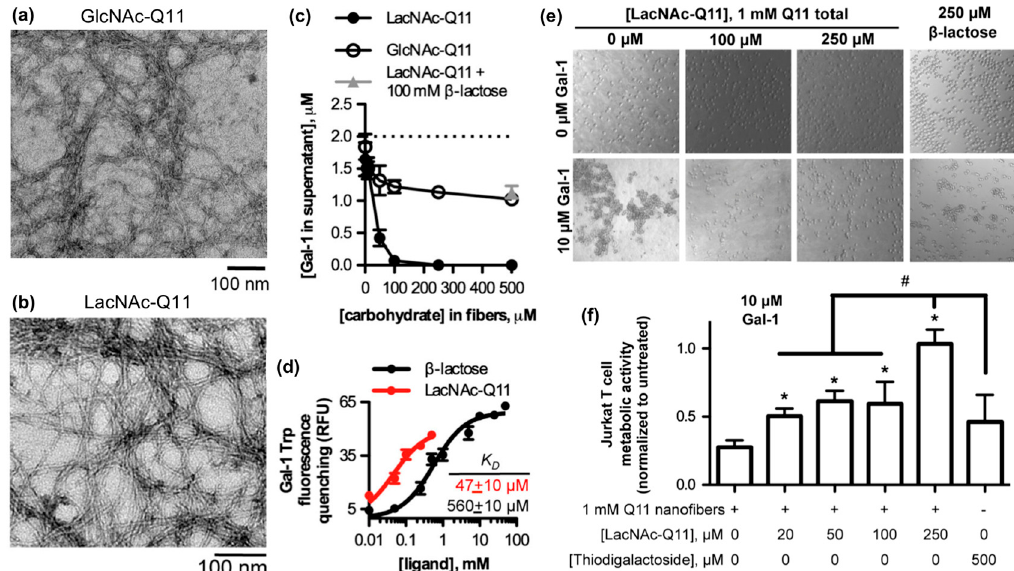
Figure 4. Glycopeptide nanofibers that bind and inhibit galectin-1. ( a ) TEM of N -acetylglucosamine (GlcNAc)-Q11 and ( b ) N -acetyllactosamine (LacNAc)-Q11 nanofibers assembled in aqueous bu ff er (pH 7.4). Images show similar fiber morphologies for GlcNAc-Q11 and LacNAc-Q11 fibers. ( c ) Binding of 2 µ M Galectin-1 to LacNAc-Q11 (black circle) or GlcNAc-Q11 (hollow circle) nanofibers with 0–500 µ M LacNAc or GlcNAc and ( d ) tryptophan fluorescence quenching of Galectin-1 by LacNAc-Q11 nanofibers or soluble β -lactose. Panel ( c ) also demonstrates inhibition of LacNAc-Q11 and Galectin-1 binding via β -lactose (triangle). ( e ) Bright-field photomicrographs of Jurkat T-cell agglutination and ( f ) metabolic activity of Jurkat T cells in culture media with or without Galectin-1 in the presence of Q11 nanofibers with di ff erent LacNAc content. LacNAc-Q11 nanofibers inhibited agglutination of Jurkat T cells induced by Galectin-1, whereas β -lactose was less e ff ective. Likewise, LacNAc-Q11 nanofibers ine ff ective. * represents p < 0.05 compared to 0 µ M LacNAc-Q11 or, # represents p < 0.05 compared